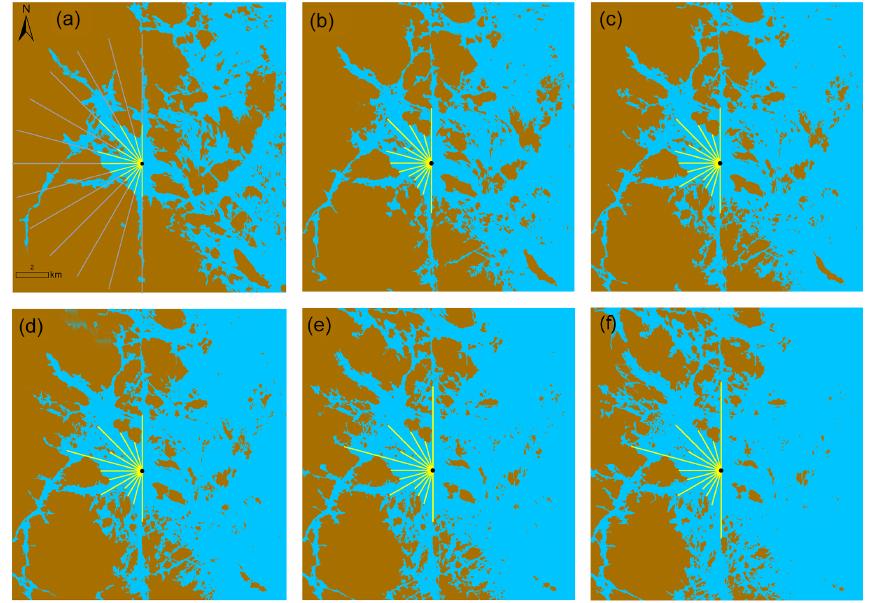
Figure 5. Illustrations showing the variations in landward radial lines intercepted with land over the last 5.4ky: (a) 0.1calkaBP,